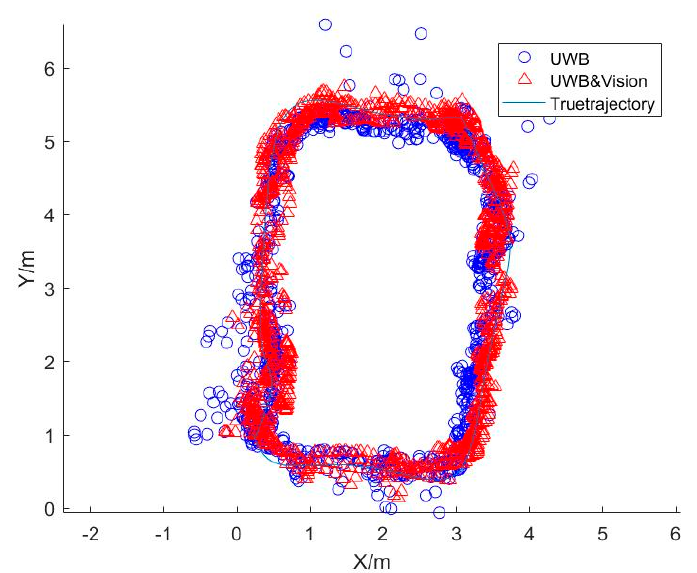
Figure 9. The positioning results.